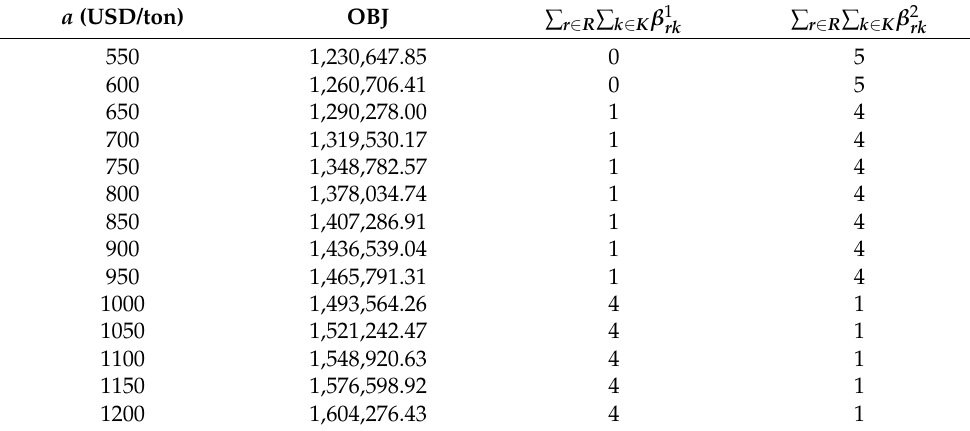
Table 5. Impact of the fuel price on the operation